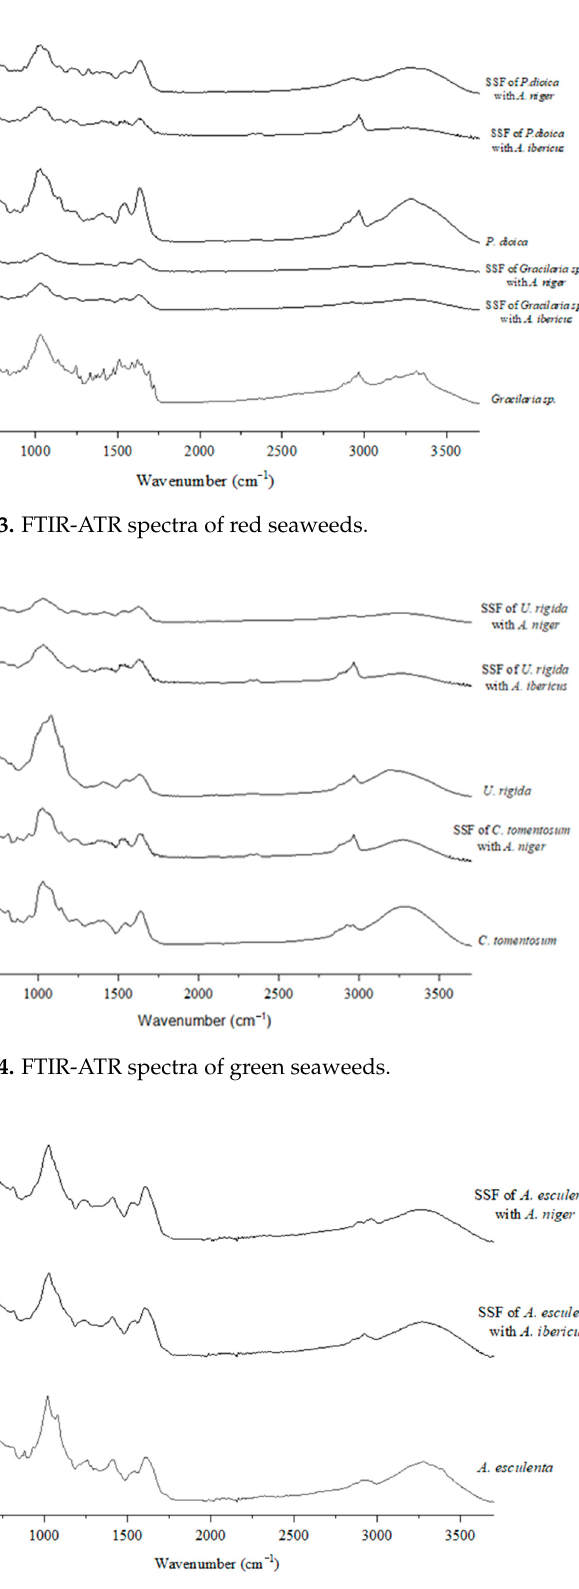
Figure 5. FTIR-ATR spectra of brown seaweed.